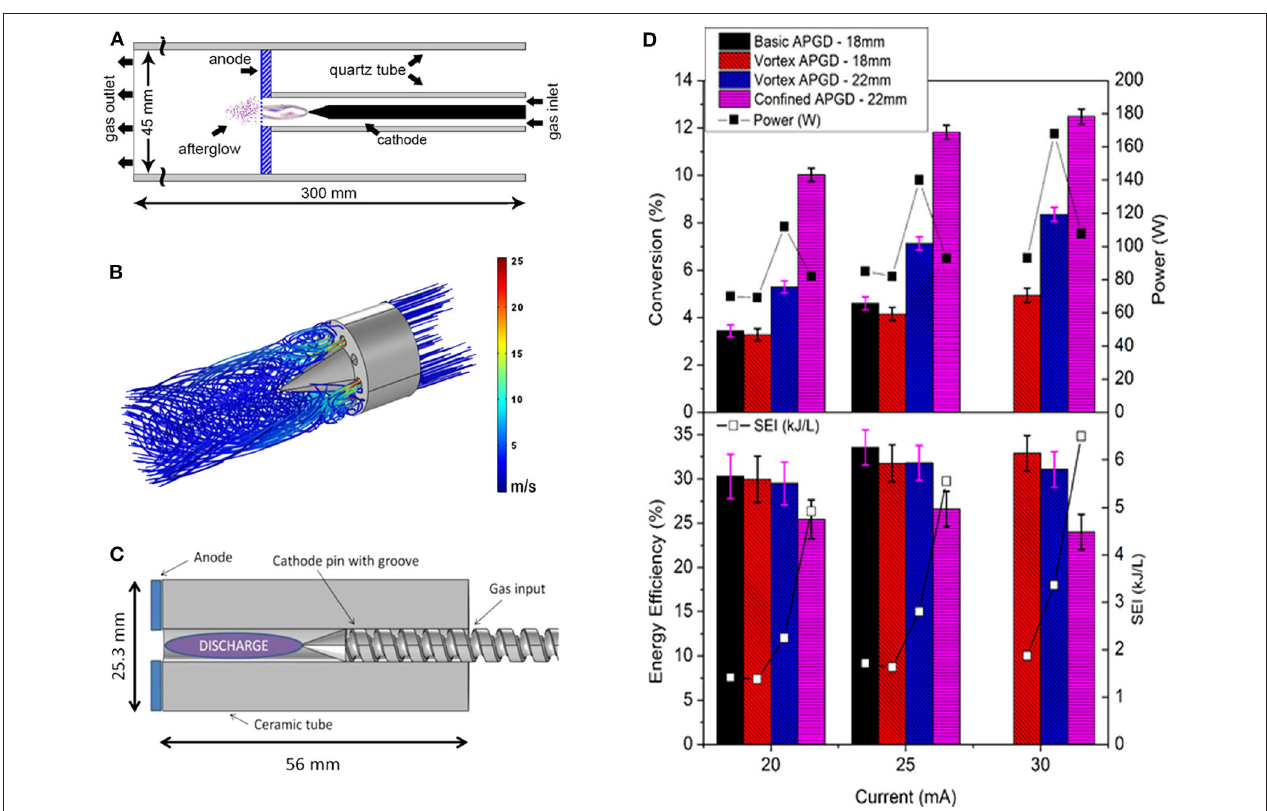
FIGURE 13 | Schematic illustration of the basic (A) , vortex (B) , and confined (C) APGD designs, as well as (D) conversion and energy efficiency obtained in these setups, at atmospheric pressure, at three different currents. The plasma power and corresponding SEI are also illustrated in (D) . Adopted from Trenchev et al. (2019) with